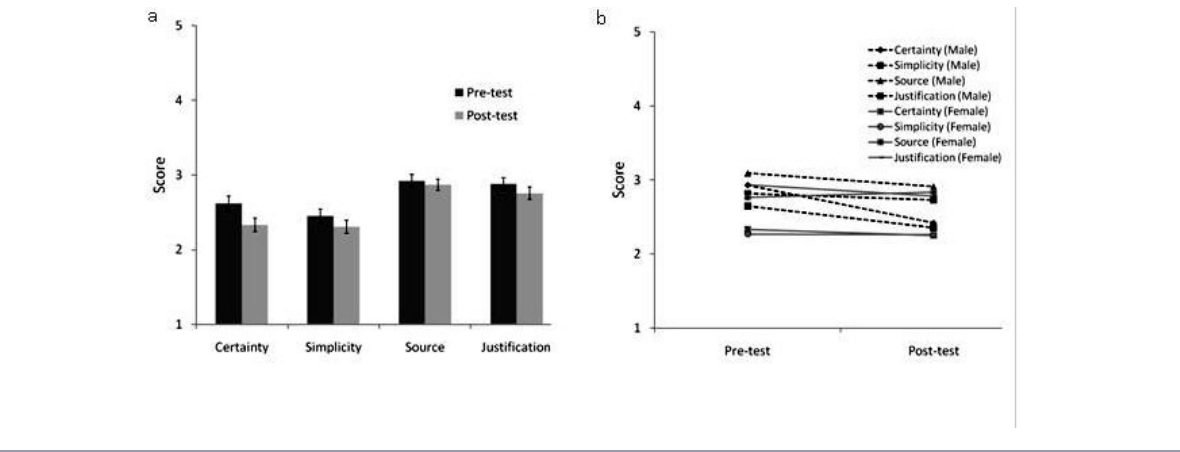
Fig. 1 . (a) Average scores for the different dimensions of epistemological beliefs for all students before and after teaching Resilience Thinking (n = 24); (b) Average scores for the different dimensions for males and females before and after the teaching intervention (n = 24). Error bars are standard error. Low scores relate to more sophisticated PEBs as defined by Hofer